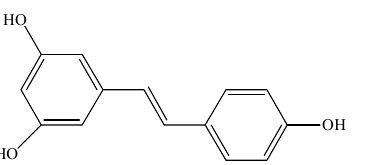
Figure 1. Chemical structure of the employed resveratrol drug.